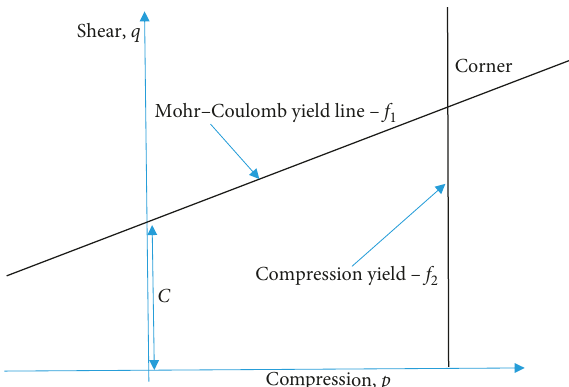
Figure 4: Schematic diagram of two interacting yield